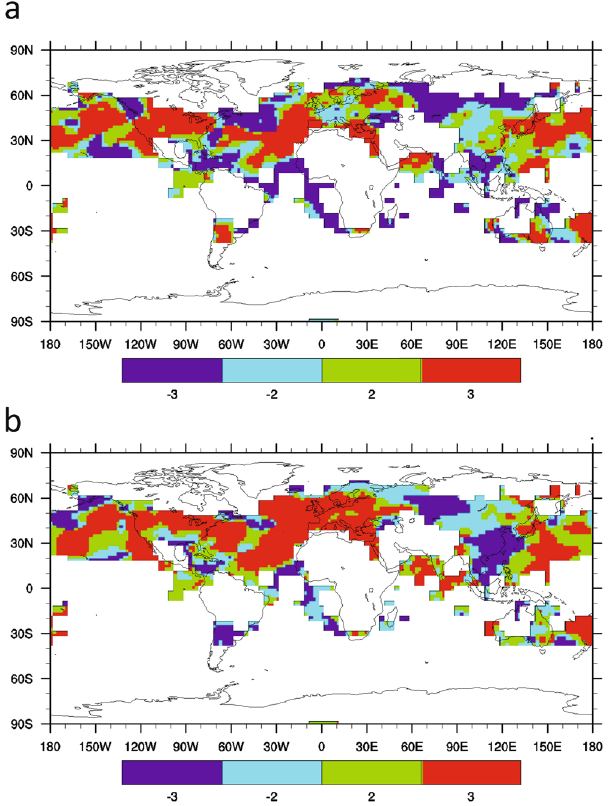
Figure 4. Consistency in autocorrelation and variance trends between temperature datasets. Monthly temperature datasets HadCRUT4, GISTEMP and ERA-40 in the interval 1957–2002, processed with filtering bandwidth 10 years and sliding window length 25 years. ( a ) AR(1). ( b ) Standard deviation. Red (3) indicates all 3 datasets agree on a positive trend, dark blue ( − 3) indicates all 3 datasets agree on a negative trend, green (2) indicates 2 datasets give a positive trend, 1 gives a negative trend, cyan ( − 2) indicates 2 datasets give a negative trend, 1 gives a positive trend. Maps were created using NCAR Command Language (Version 6.2.1) [Software]. (2014). Boulder, Colorado: UCAR/NCAR/CISL/TDD.